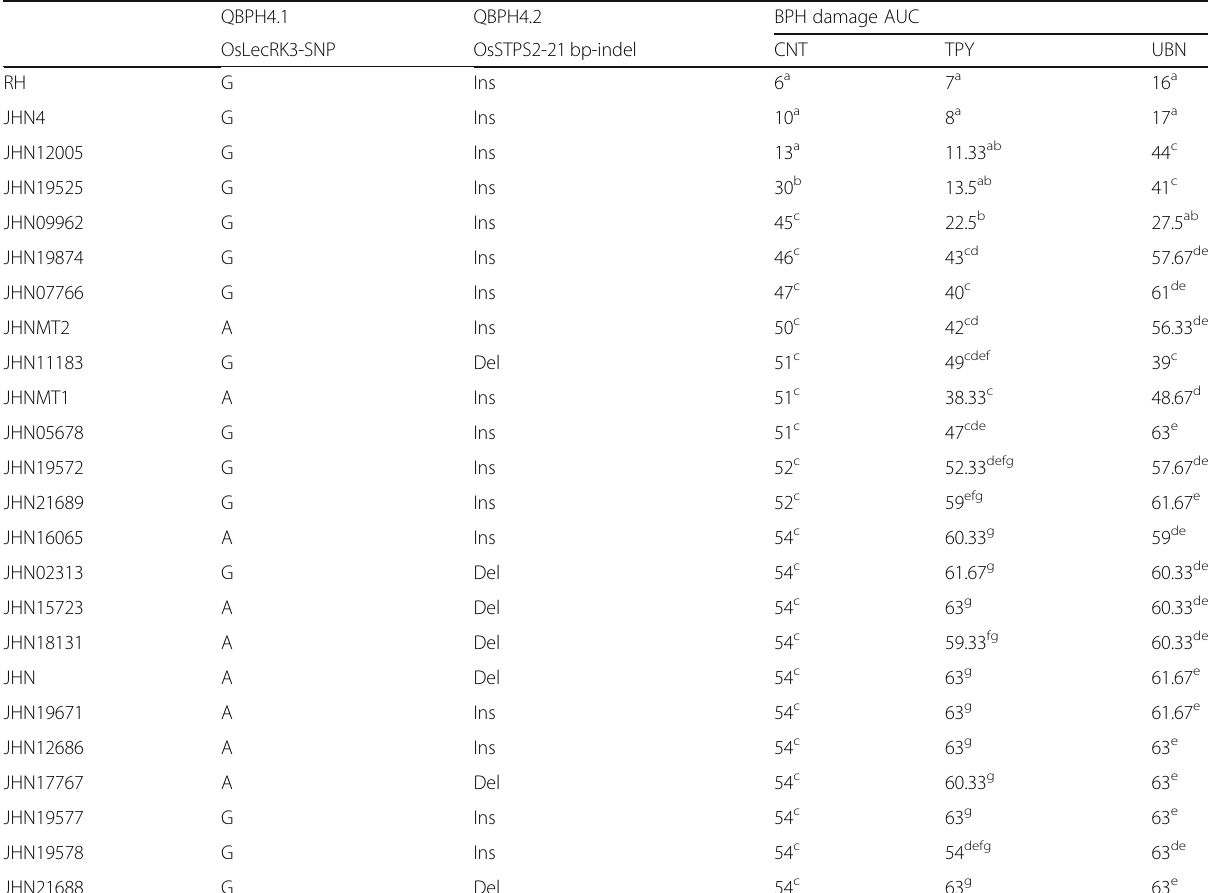
Table 4 Genotyping data at two loci used for reverse screening of selected mutant lines and BPH damage AUC tests using 3 BPH populations. The “ Ins ” indicated insertion allele while “ Del ” indicated deletion allele of the OsSTPS2-21 bp-indel marker. Letter a, b, c, d, e, f, g indicated similarity of the traits in multiple comparison